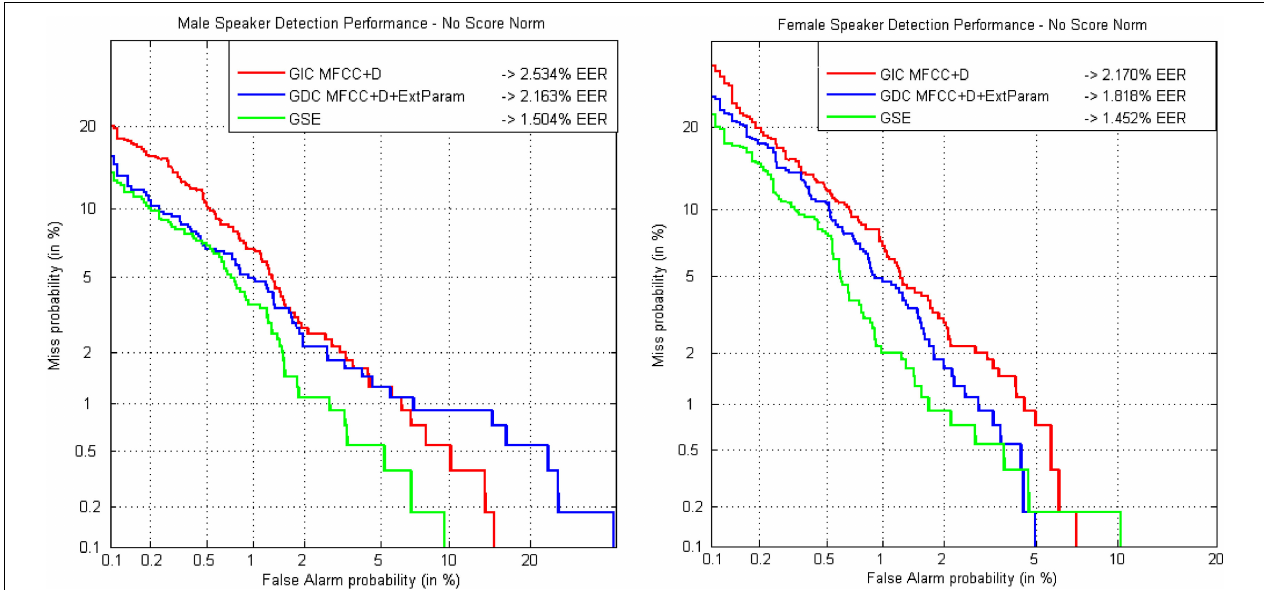
FIGURE 6 | DET curves comparing classical parameters in a gender-independent setup with the GDEB parameterization on ALBAYZIN development set for male (left) and female (right) speakers .